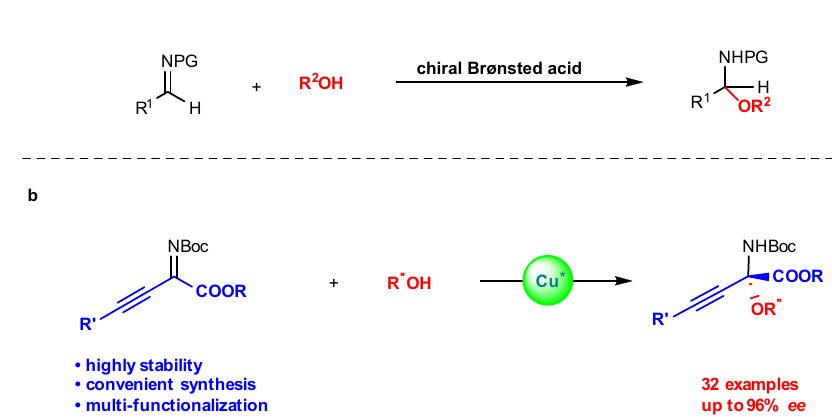
Fig. 2 Catalytic asymmetric addition of O -nucleophiles to linear imines. a Previous work: synthesis of linear chiral N , O -acetals. b This work: synthesis of linear chiral N , O